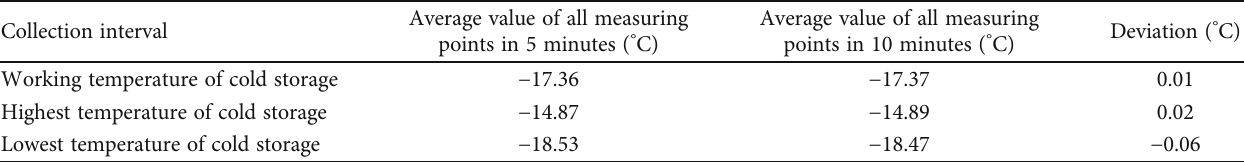
Table 3: Comparison of the results of di ff erent collection time intervals at the intermediate temperature measurement points in the cold storage.